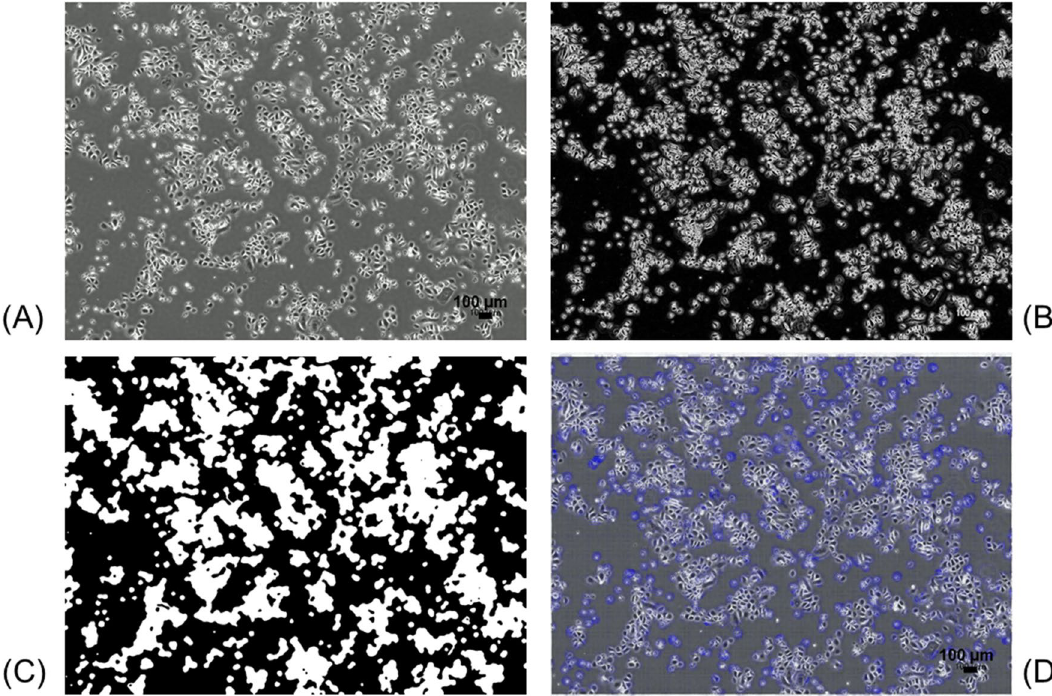
Figure 5. Images of pre-processing to calculate the MS by OF algorithm. ( A ) Representative original phase- contrast microscopic image of the p1 oral keratinocytes of the first frame of time-lapse microphotography. Cells are grown at approximately 50% confluence. ( B ) Illustration of edge detection for ( A ). Edges are detected by combining the horizontal and vertical derivatives using the square root of the sum of squares after 3 × 3 convolution kernels (Sobel filter) was applied to the image. ( C ) Illustration of the segmentation of cells/ colonies by binarisation of ( B ). Black and white areas indicate background and cell area, respectively, by using the variational segmentation method of Chan and Vese. ( D ) Displacement vectors to be calculated by the OF algorithm in ( A ) are shown. By using the OpenCV library (ver.4.1), this full-screen image and the image at the next time step were used to calculate the MS as the mean value of the magnitude of vectors. The original video file is provided in Supplementary Video